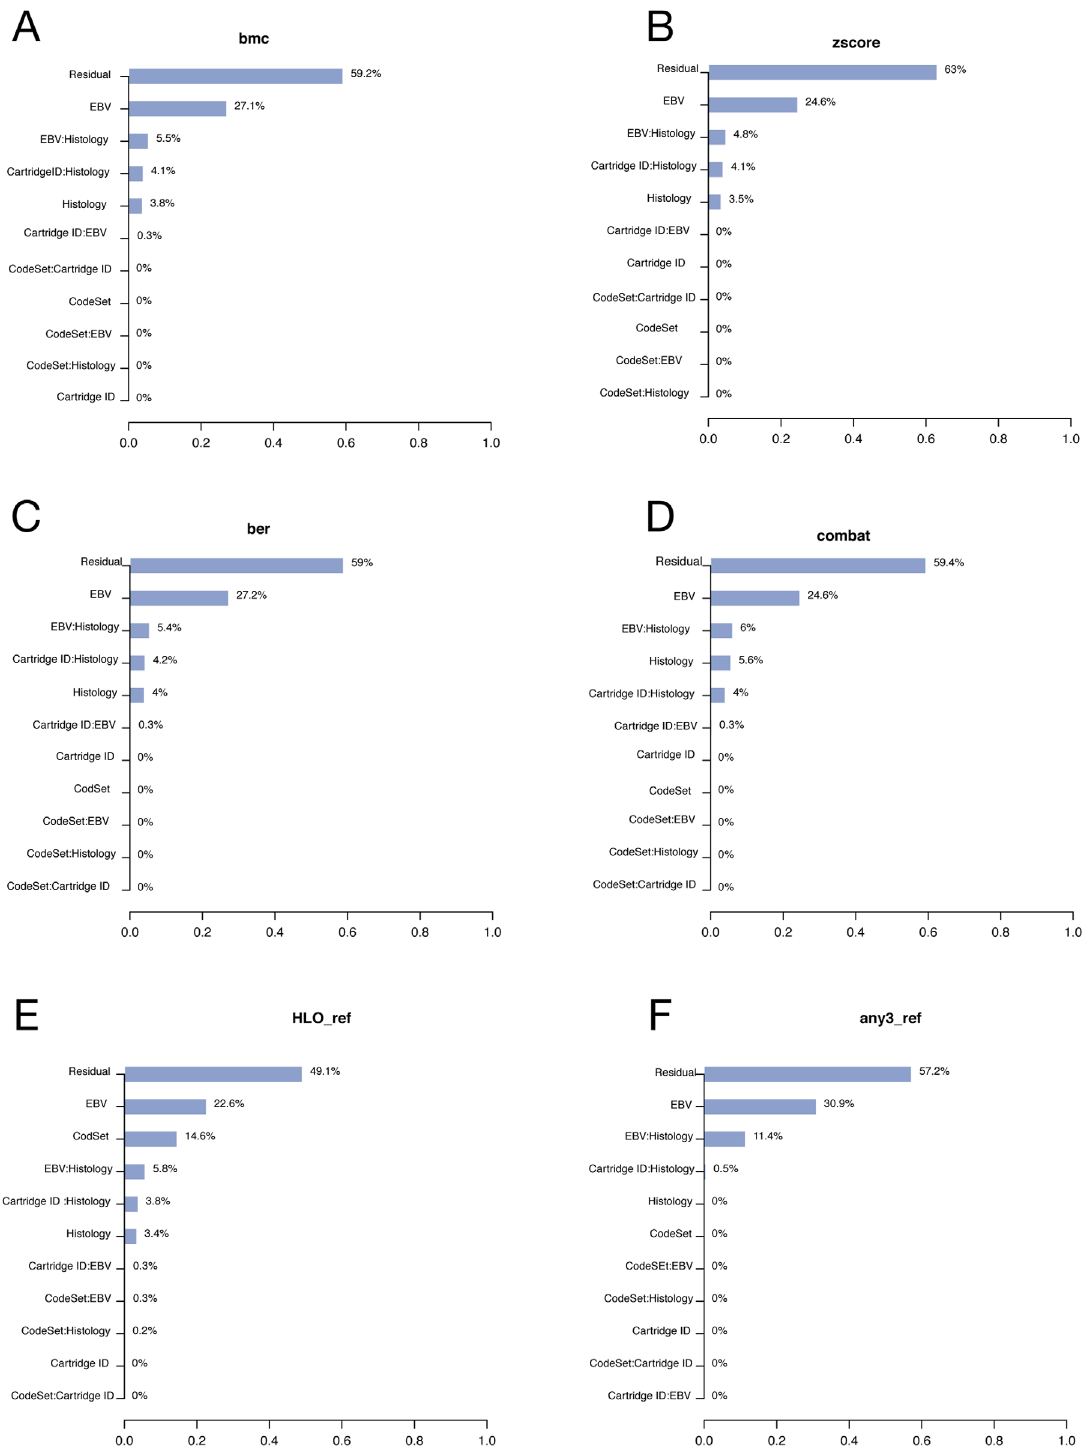
Fig 5. PVCA of the HL clinical samples after adjusting batch effect using different methods. We consider the PVCA plot of the HL clinical samples run in different batches after adjusting BE with different methods. In each plot, percentages represent the variability explained by each factor and first order interaction between